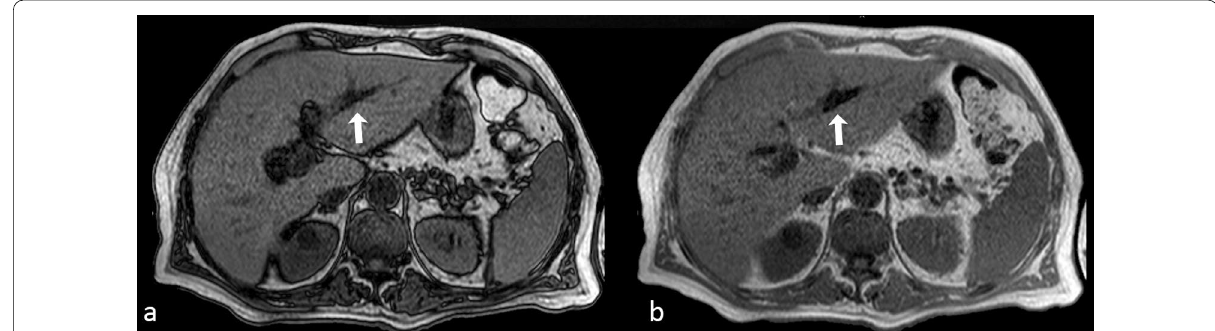
Fig. 6 Axial opposed-phase ( a ) and in-phase ( b ) GE images showing a linear susceptibility-related artifact in the left hepatic duct, consistent with pneumobilia. The hypointensity is more conspicuous on the in-phase image